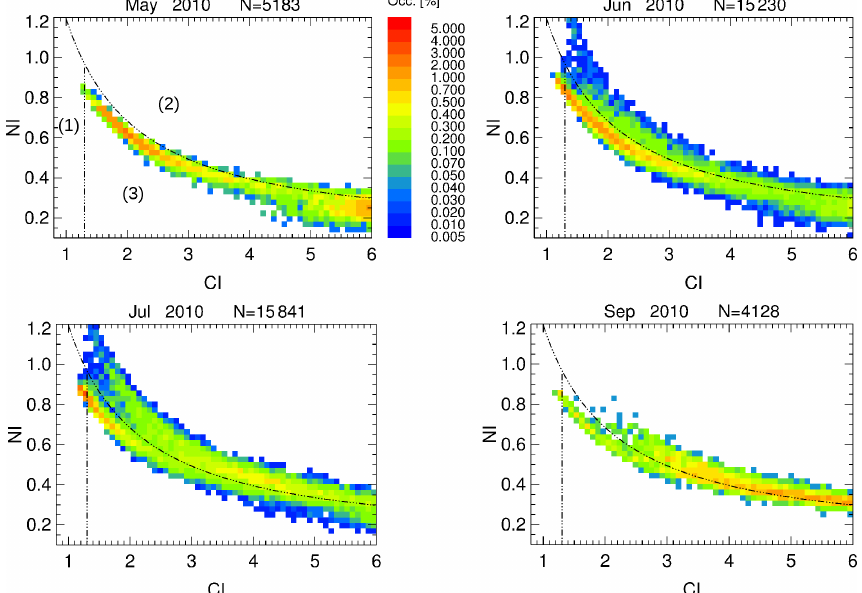
Figure 3. Probability density functions for cloud index (CI) vs. NAT index (NI) for Southern Hemisphere 2010 winter for the months May, June, August, and September (May 2007–September 2007) derived from MIPAS measurements in the altitude range 16–30km. The percentage of occurrence with respect to the number of observations ( N obs ) in SH polar cap region south of 55 ◦ S are colour-coded. The cloud type regions and separating lines are superimposed: region (1) for ice with overlap of high volume density STS (acronym ICE_STS H06 ; see also Table 2), region (2) for small NAT (sNAT3 H06 ) particles, and region (3) for STS particles with overlap of large NAT particles (STS_ l NAT H06 ) based on Höpfner et al. (2006a). Table 2. Predefined PSC type probability matrix for the Bayesian classifier (V1.2.8).